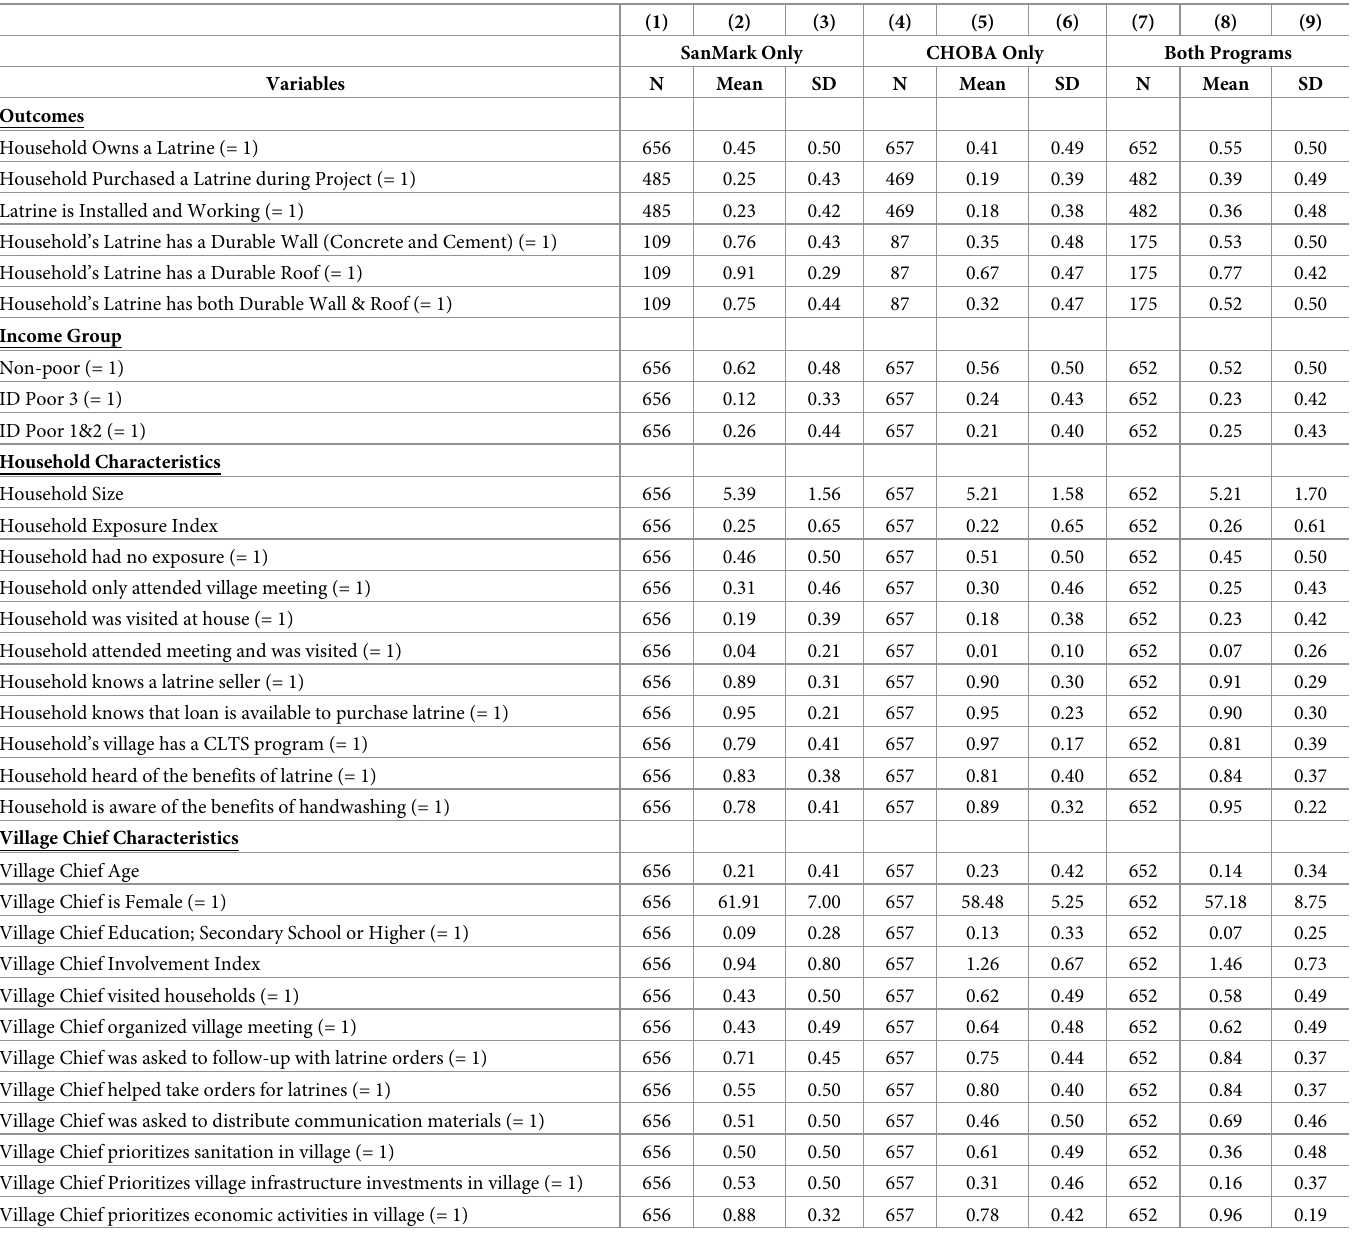
Table 3. Summary statistics at the household level by village